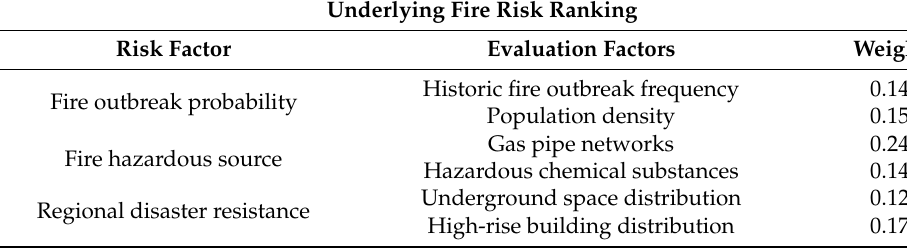
Table 2. Fire risk ranking.